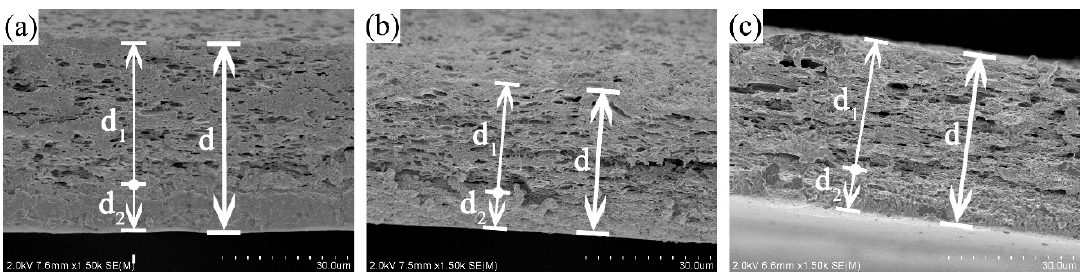
Figure 2. SEM images of the cross sections of films G ( a ), GA ( b ), and GC ( c ) [13]. Table 2. Relationship between di ff usion coe ffi cient of two layers ( D 1 and D 2 [13]) of film G, GA, and GC. Film